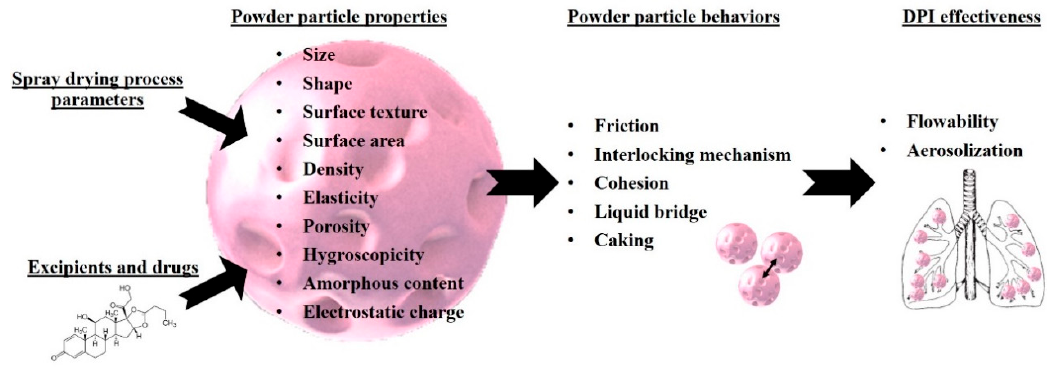
Figure 8. Powder particle properties impacting powder behaviors and consequently, the effectiveness of DPI.